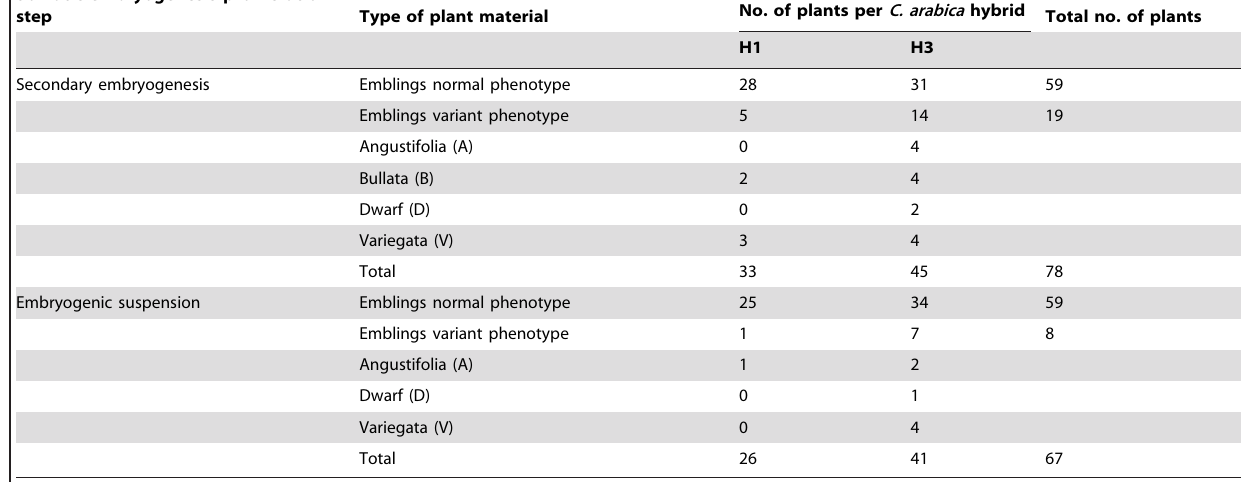
Table 8. Plant material used in molecular marker